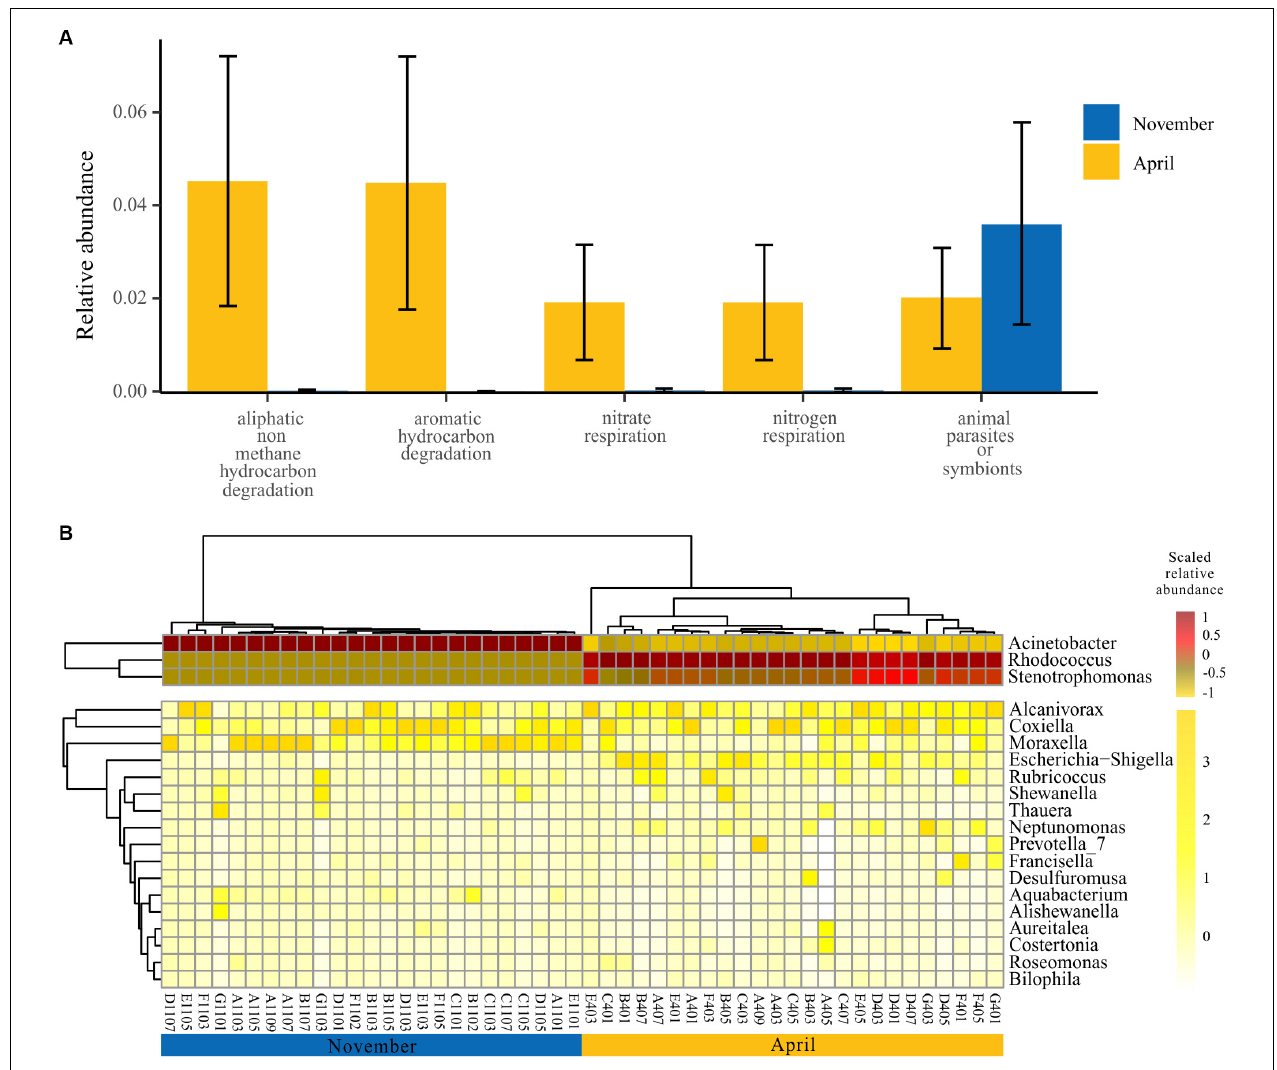
FIGURE 5 | Specific bacterial functions of two seasons. (A) Biomarker functions with higher relative abundance in two seasons. The eight biomarker functions were identified by applying the random-forest classification of the relative abundance of the bacterioplankton communities against November and April. Data bars represent means. Error bars represent SEM. (B) The spatial and temporal dynamics of bacterioplankton genera that drive the biomarker